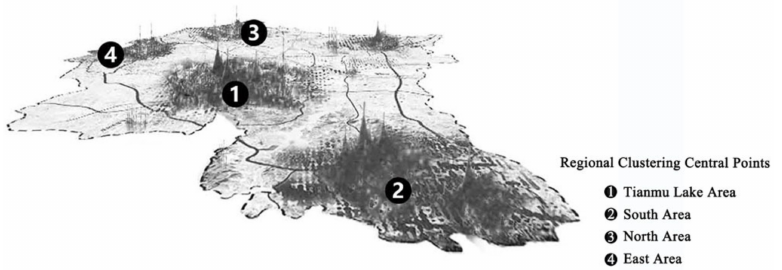
Figure 8. Layer overlay result map.